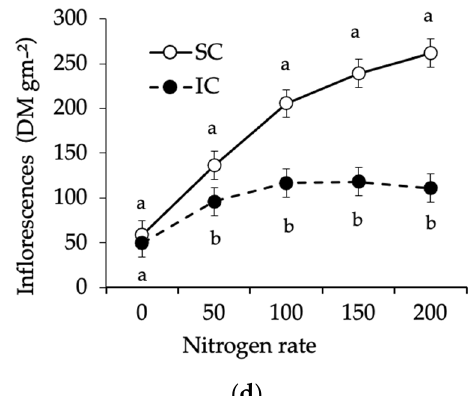
Figure 3. Cropping system × nitrogen rate interaction effect on the forage production (DM g m − 2 ) of barley: ( a ) aerial plant part; ( b ) leaves ( c ) stems; ( d ) inflorescences. Values are means of two years, two harvesting stages, and three replicates. Vertical lines represent HSD and values with the same letter are not statistically different for p ≤ 0.05. SC = sole crop; IC = intercrop.